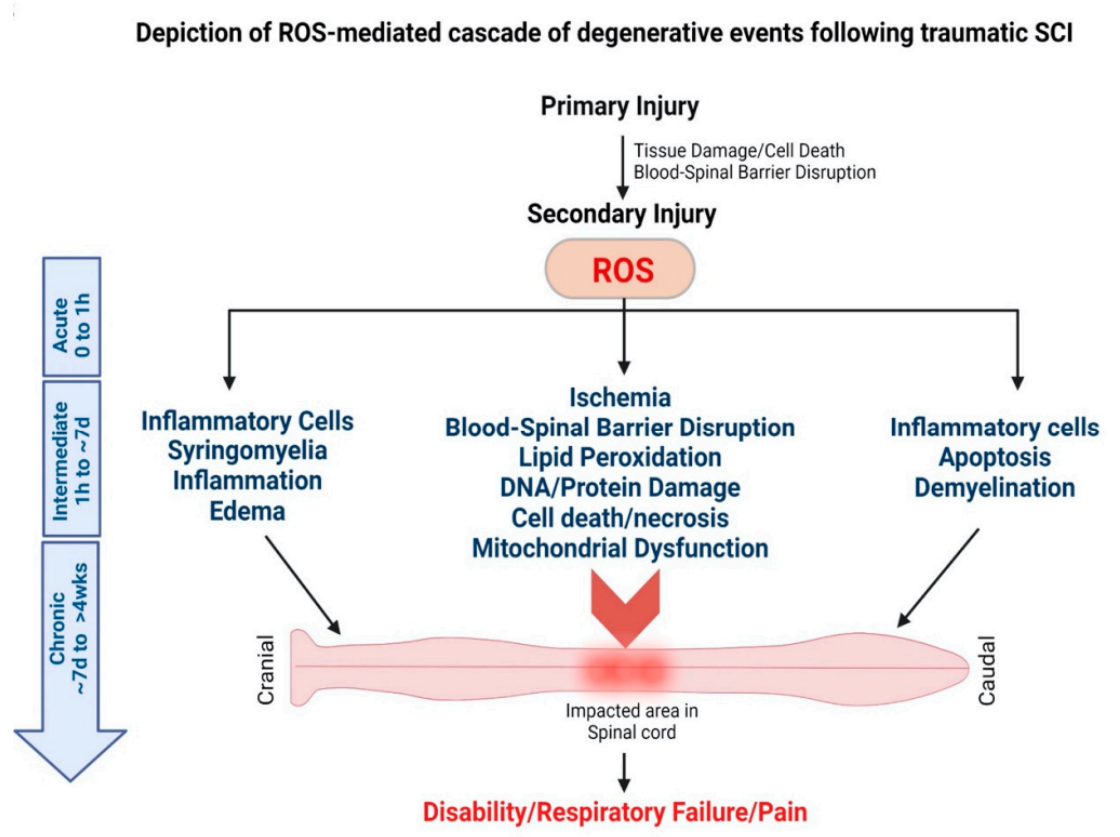
Figure 3. Secondary injury cascade following spinal cord injury. Traumatic injury to the spinal cord leads to secondary injury progression that affects the lesion site and the entire spinal cord, including the cranial and caudal segments of the spinal cord. Following injury, excessive production of ROS is considered to trigger the secondary injury cascade of progressive degeneration that affects the entire spinal